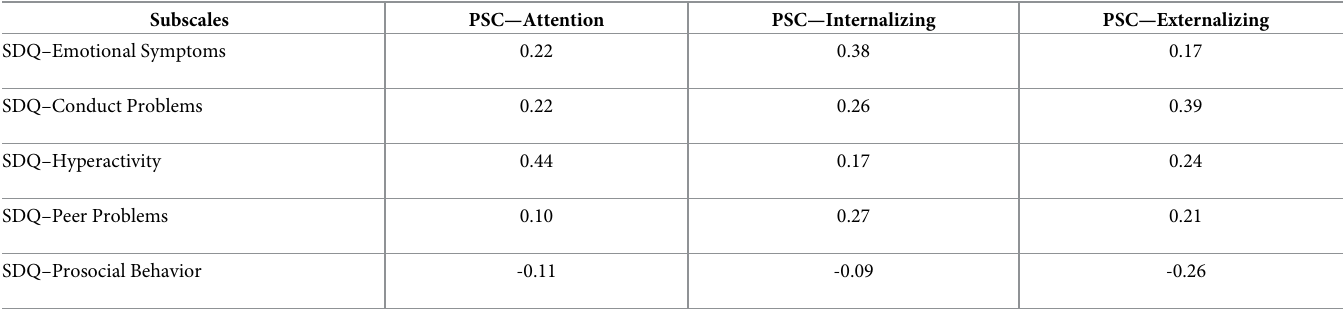
Table 6. Spearman correlation between PSC-16-Y and